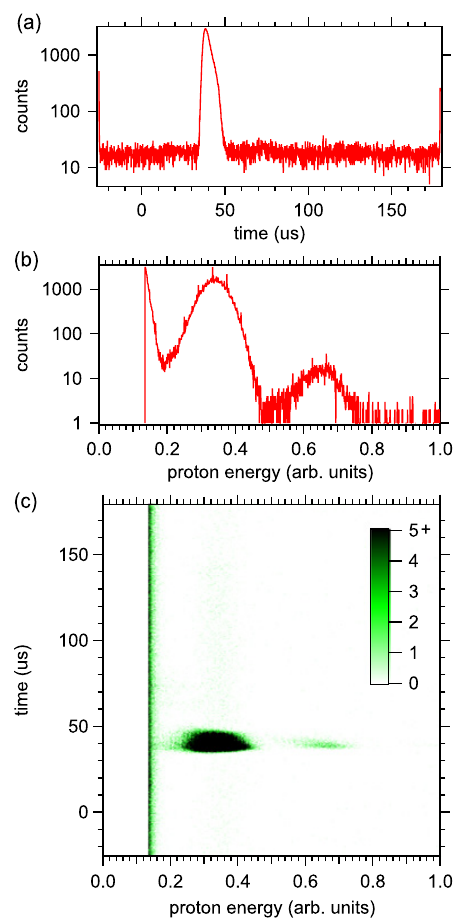
Figure 5. An example of the preamplifier proton pulse (solid red) and the output of the trapezoid filter optimized for energy extraction (dashed black) or time resolution (dotted